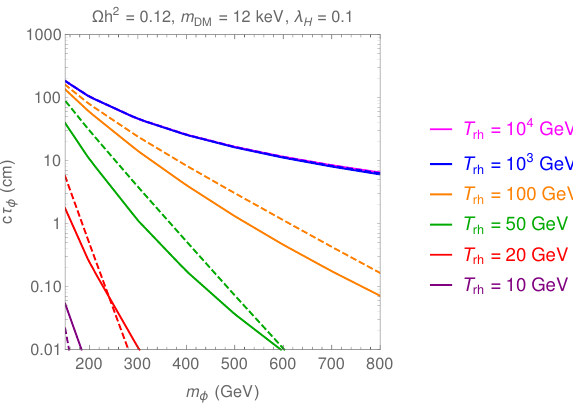
Figure 14. Comparison between our implementation of T R (continuous curve) and a cut in the time integration of the DM yield as in e.g. [23,